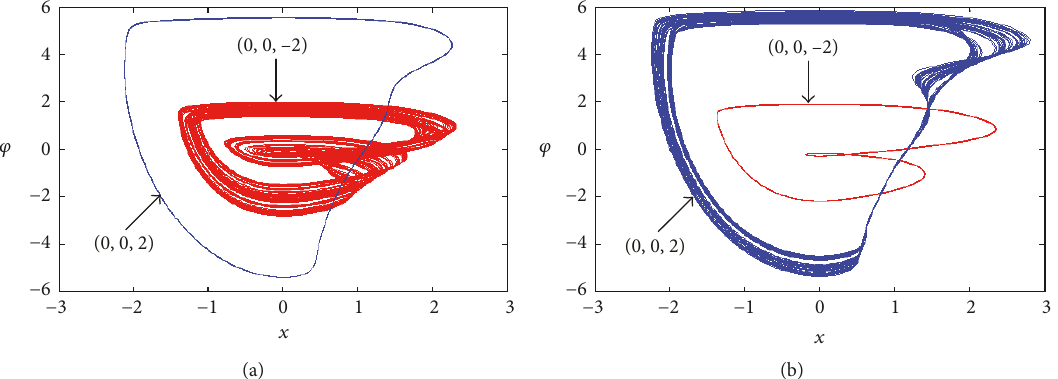
Figure 7: Phase portraits in the 𝑥 - 𝜑 plane for the other two types of hidden coexisting asymmetric attractors. (a) 𝐼 = 1.15 and 𝑘 = 0.9. (b) 𝐼 = 1.62 and 𝑘 = 0.9.